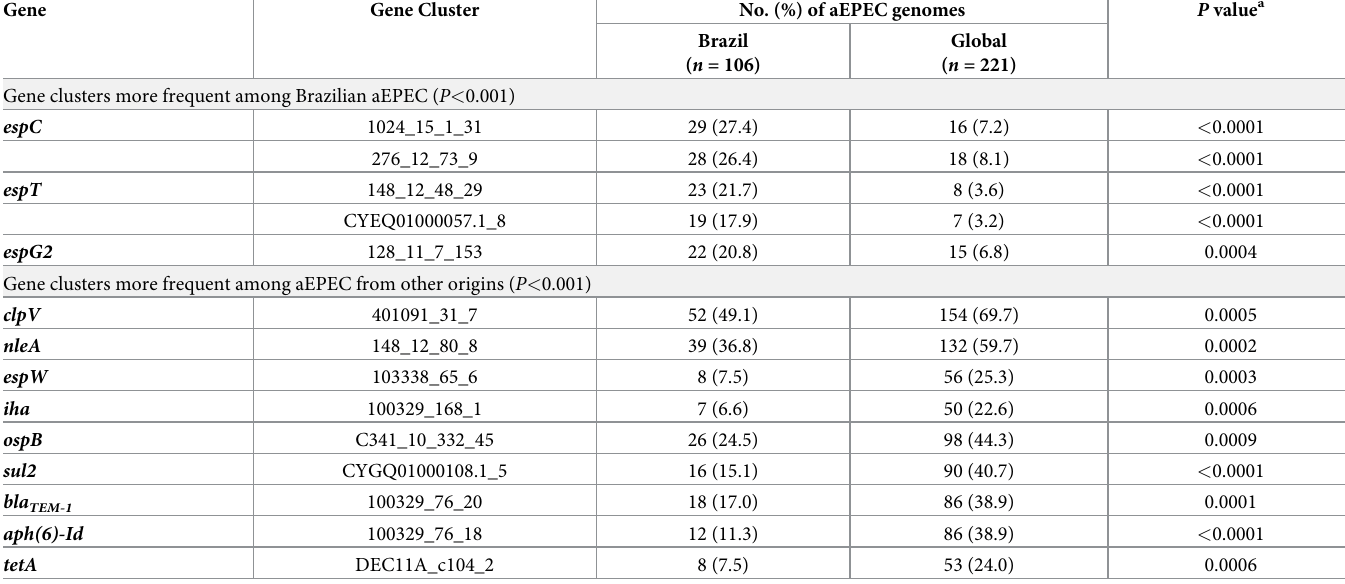
tetA a Differences in the prevalence of gene clusters among the two groups of aEPEC studied (Brazilian aEPEC versus Global aEPEC) were tested using the Chi-square test with Yates